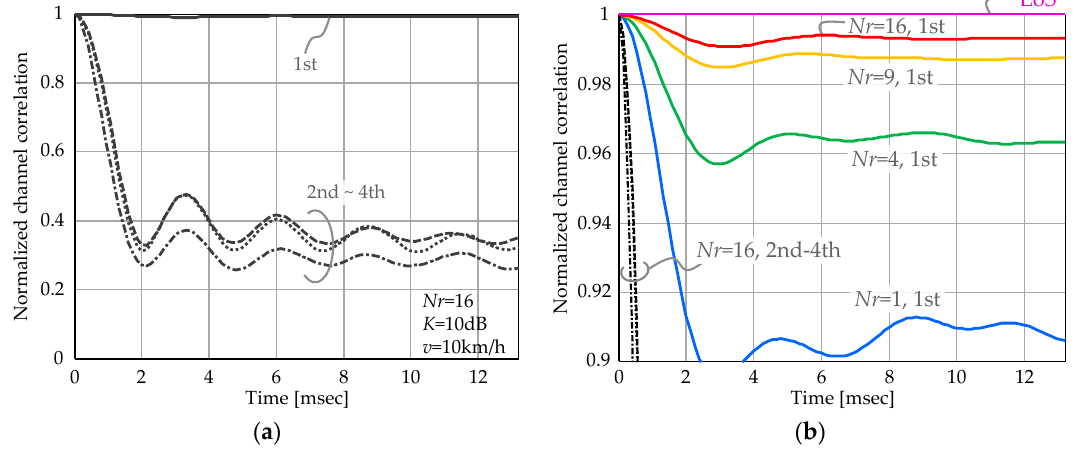
Figure 2. Channel time variation: ( a ) channel correlation fluctuation of four eigenmodes when Nr = 16; and ( b ) channel correlation of the 1st eigenmode with increased number of UE antenna elements, Nr .